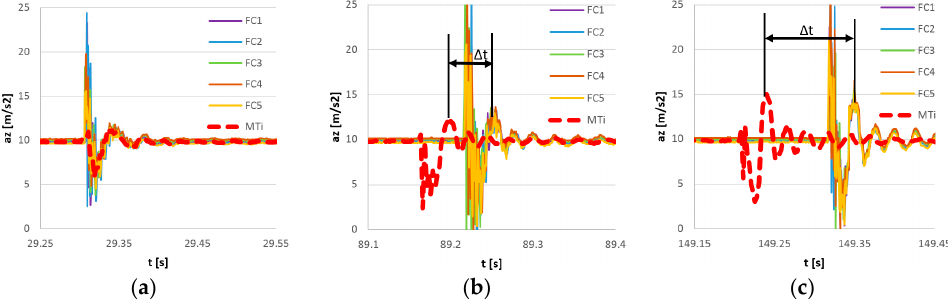
Figure 15. Measurement of impulse excitation by five flight controller sensors (FC1–FC5) after the synchronization and reference signal measured with the Xsens MTi-G700 sensor (MTi). Magnification of the initial ( a ), middle ( b ), and last pulse ( c ). ∆ t: shift between the reference pulse and the FC pulse.